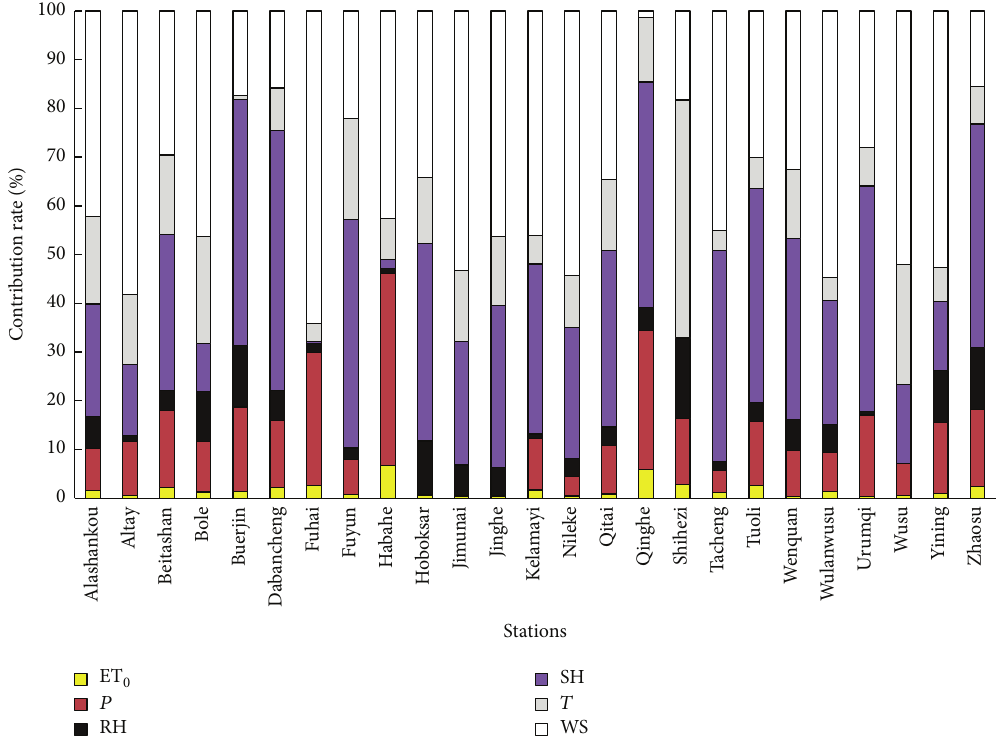
Figure 8: Percentage of contribution rate of meteorological factors to AI changes in North Xinjiang,